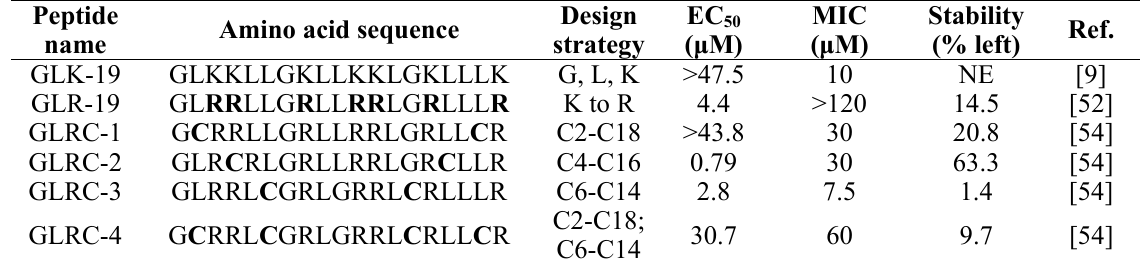
Table 3. Database-guided design of anti-HIV peptides 1